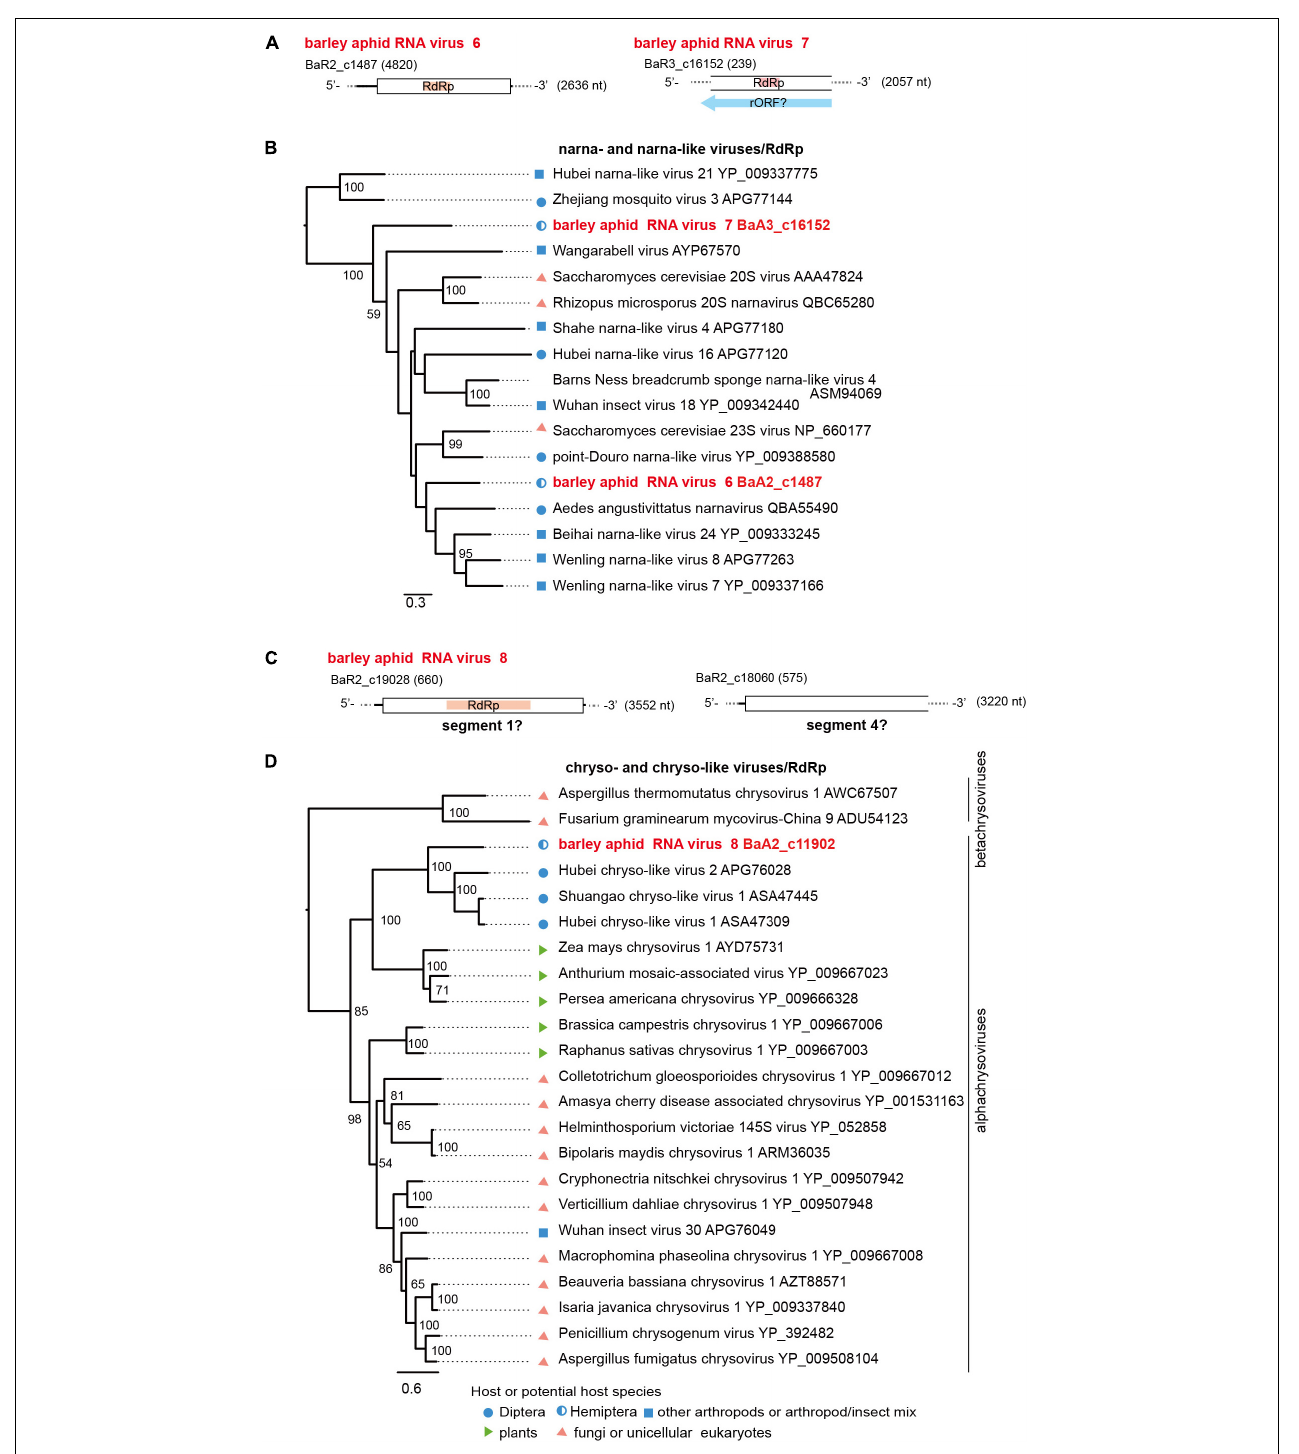
FIGURE 6 | Genome organizations and phylogenetic relationships of narna- and narna-like viruses (A,B) and chryso-and chryso-like viruses (C,D) . (A,C) The genome structures of two novel narna-like viruses (named barley aphid RNA virus 6 and 7, BARV-6 and -7) in panel (A) and a chryso-like virus (named barley aphid RNA virus 8, BARV-8) in panel (C) . rORF: reverse-frame ORF. (B,D) Phylogenetic relationships of two novel narna-like viruses BARV-6 and -7, yeast narnaviruses and invertebrate narna-like viruses (B) , and BARV-8, chrysoviruses (the members of genus Alphachrysovirus ) and chryso-like viruses (D) . The ML trees were constructed using multiple amino acid sequence alignments of the RdRp sequences. Two narna-like viruses (Zhejiang mosquito virus 3 and Hubei narna-like virus 21) (B) or some members of genus Betachrysovirus (D) were used as the outgroups, respectively. The scale bar represents amino acid distances. The numbers at the nodes are bootstrap values of >